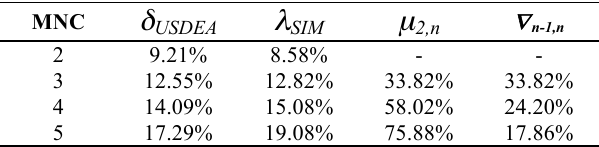
Table 10. Effect of Increasing MNC, Communications